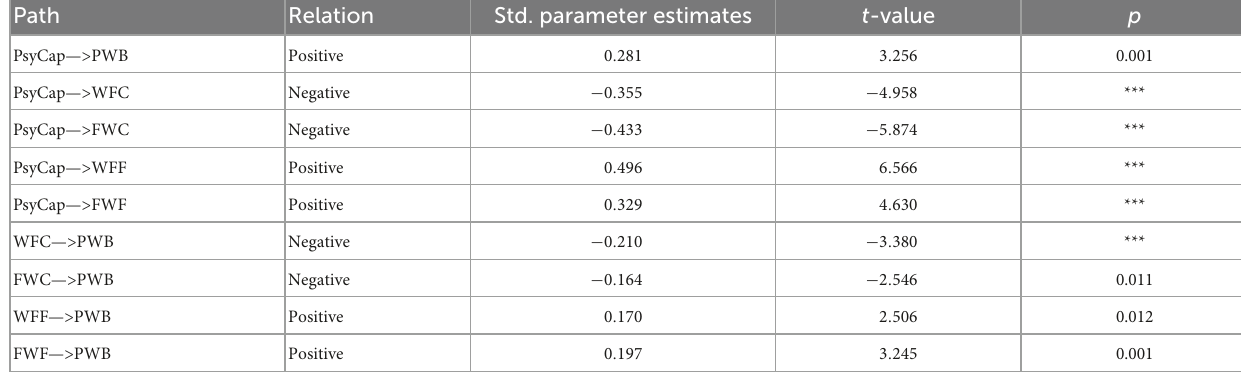
TABLE 3 Results for hypotheses